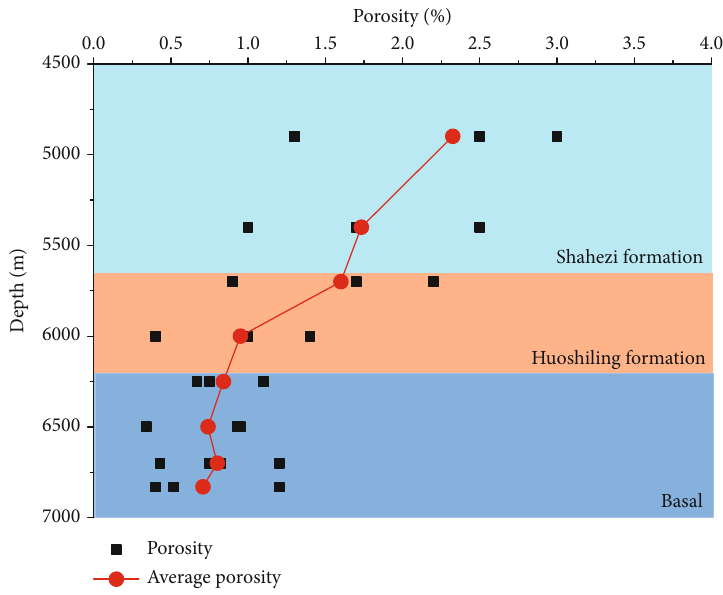
Figure 10: The porosity measured by NMR varies with depth.